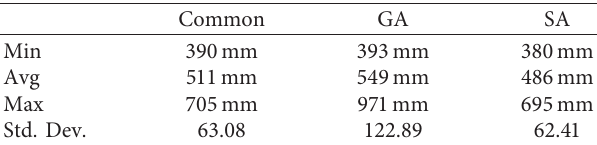
Table 3: Total parsed